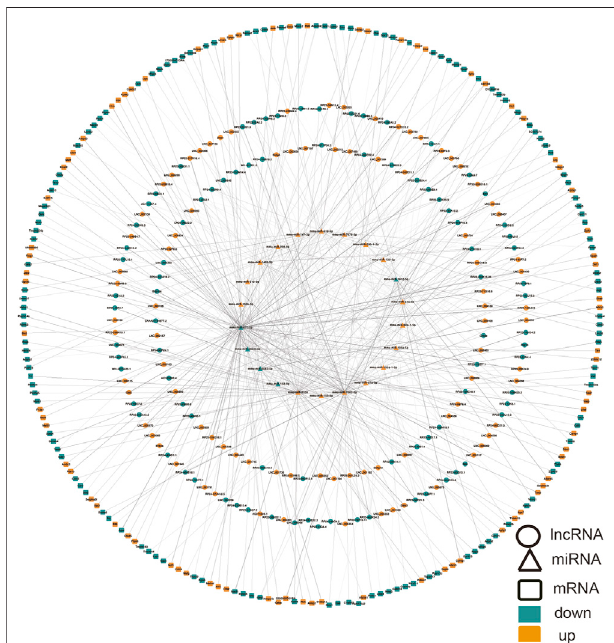
FIGURE 5 | CeRNA network in ALI involving lncRNA-miRNA-mRNA. Ellipse, DElncRNA; triangle, DEmiRNA; rounded rectangle, DEmRNA. Red node, upregulation; blue node designates downregulation. miRNA, microRNA; ceRNA, competing endogenous RNA; DE, differentially expressed, lncRNA, long non-coding RNA.